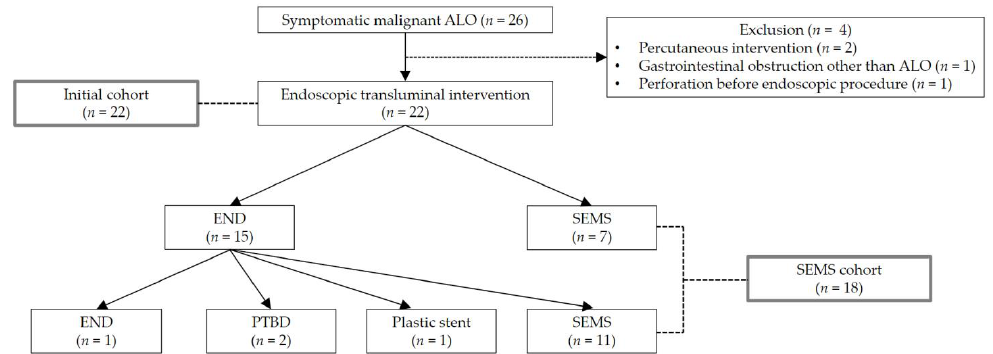
Figure 2. Study flow diagram. ALO, afferent loop obstruction; END, endoscopic naso-drainage; SEMS, self-expandable metal stent; PTBD, percutaneous transhepatic biliary drainage.